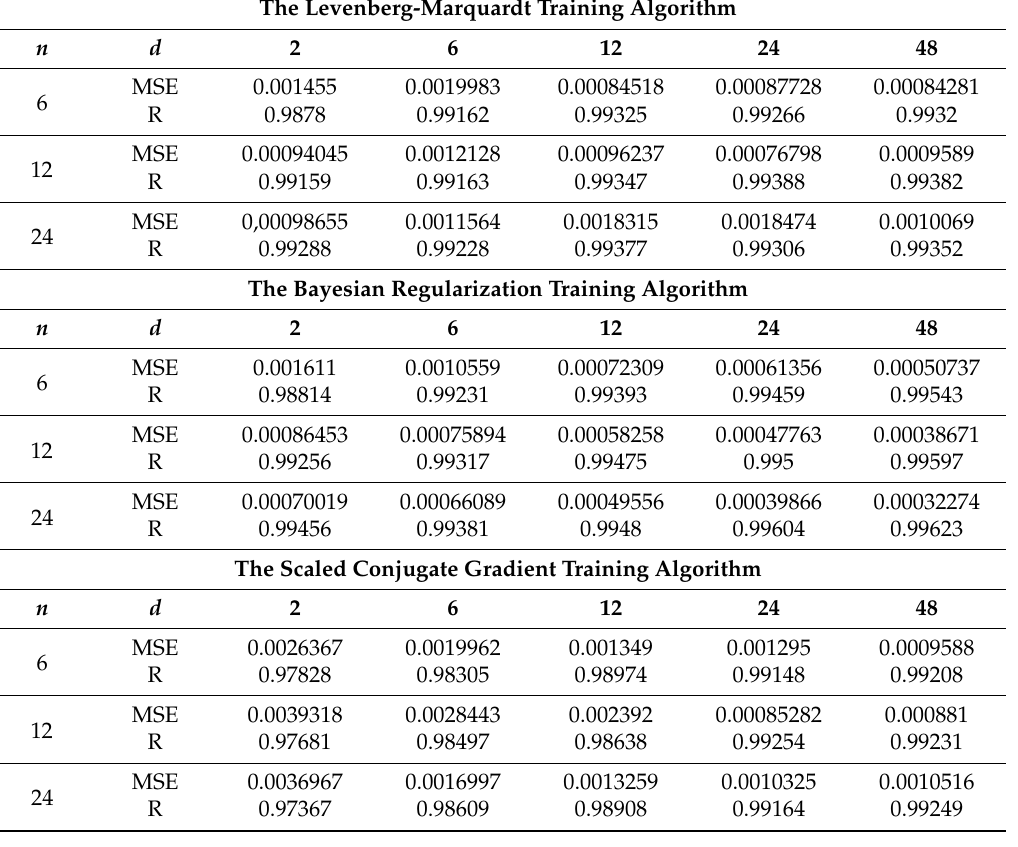
Table 4. The synthesis of the experimental results when developing the artificial neural networks forecasting solution based on the NARX model, using as exogenous variables the time stamps